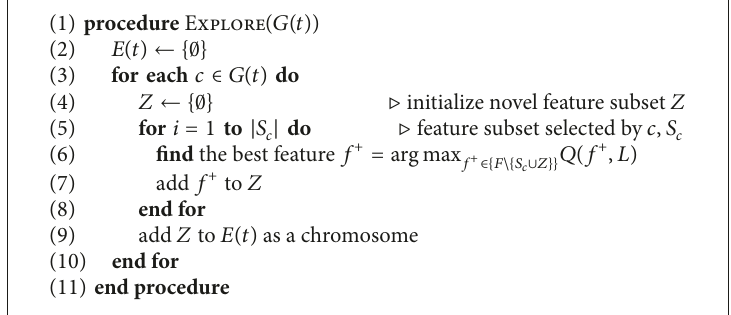
Algorithm 2: Procedures of exploration